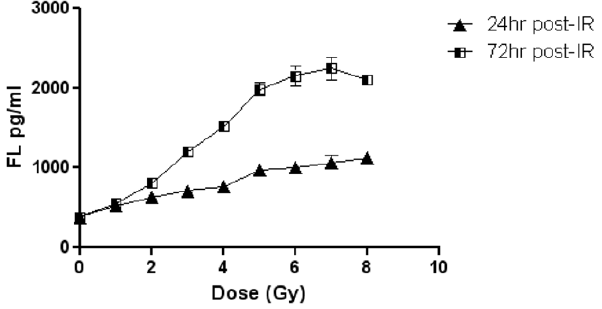
Figure 3. FL Blinded Dose Prediction Model. FL values at doses of 0–8 Gy in TBI C57BL6 mouse plasma used to generate dose prediction models for blinded dose prediction study at 24 and 72 hrs post-IR. Values reflect the mean 6 SEM.